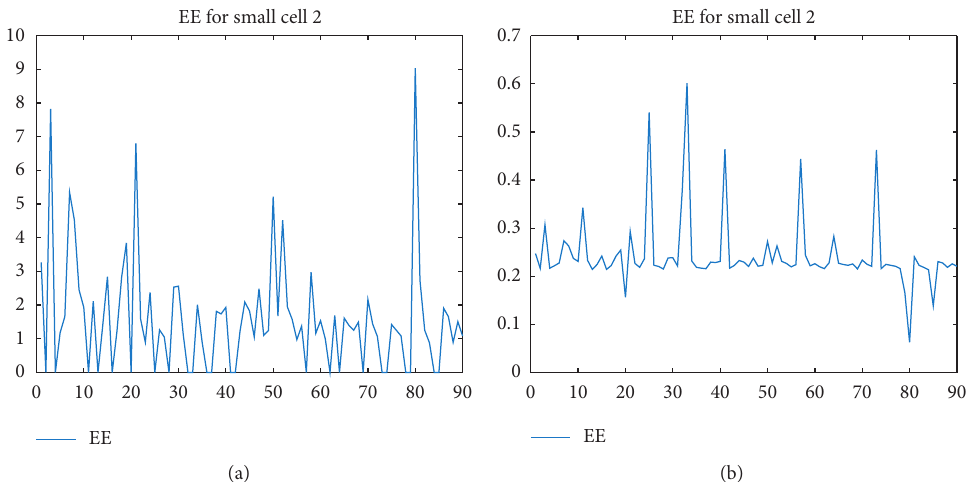
Figure 10: The energy efficiency (a) and SINR (b) of small BS 2 for 90